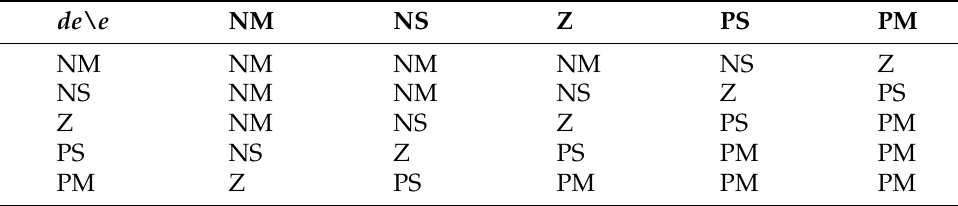
Table 1. Rule base of the fuzzy logic